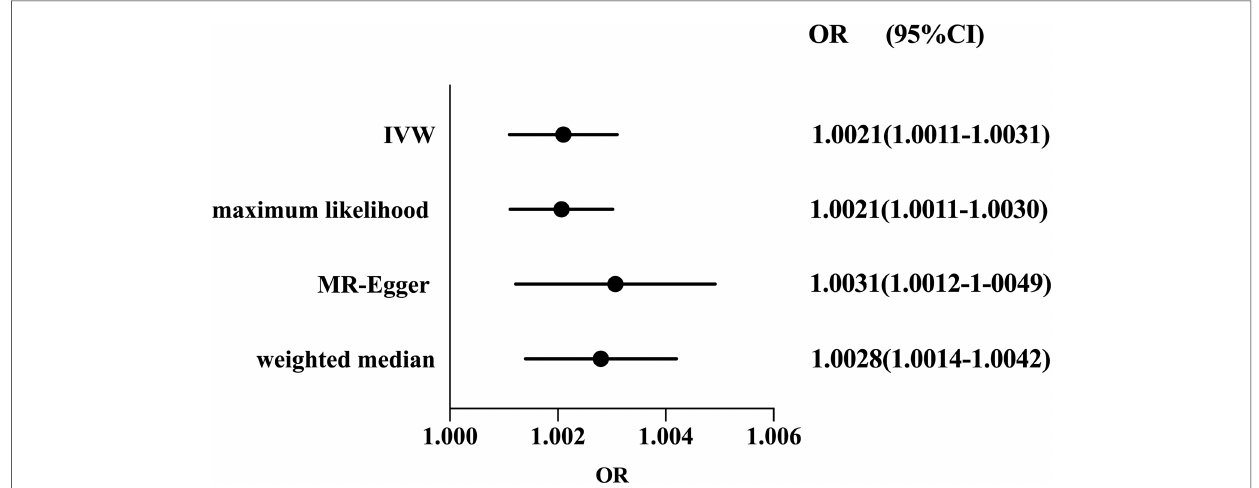
FIGURE 2 Forest plot of the effect of RA on coronary atherosclerosis risk. Forest plots of main and all sensitivity analyses. Estimates were obtained using a fi xed- effects model. The black dots represent the OR value obtained by each method and the solid line represents the 95% CI. IVW, inverse variance weighted; MR, Mendelian randomization; OR, odds ratio; CI, con fi dence interval.